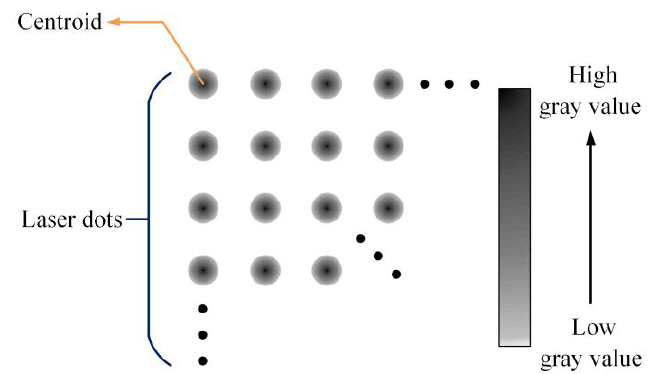
Figure 5. A filter is used to change the laser dots’ gray value, and the centroid pixels of the dots get the biggest value.